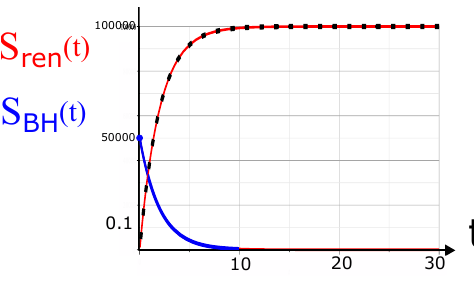
Figure 11 . Renormalized entanglement entropy (4.7) and black hole entropy (4.10) as a function of boundary time t for A = 1, (cid:11) = 50000 and c = 12. The dotted black line is the coarse-grained matter entropy, the r.h.s. of